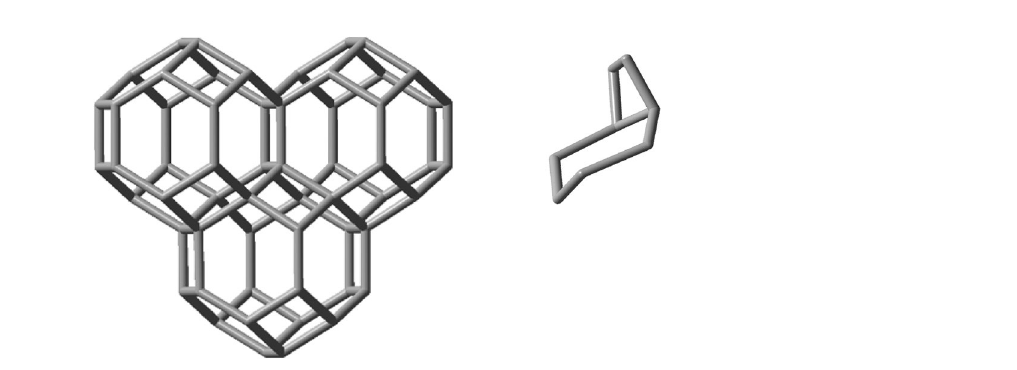
Figure 10. Left: optimized geometry of the C 58 H 46 2D-scaffold generator obtained by fusing three nugget 24a molecules. Right: the released (1R,6S)-bicyclo[4.2.0]octane molecule, C 8 H 14 , which is the product of the idealized second fusion reaction.